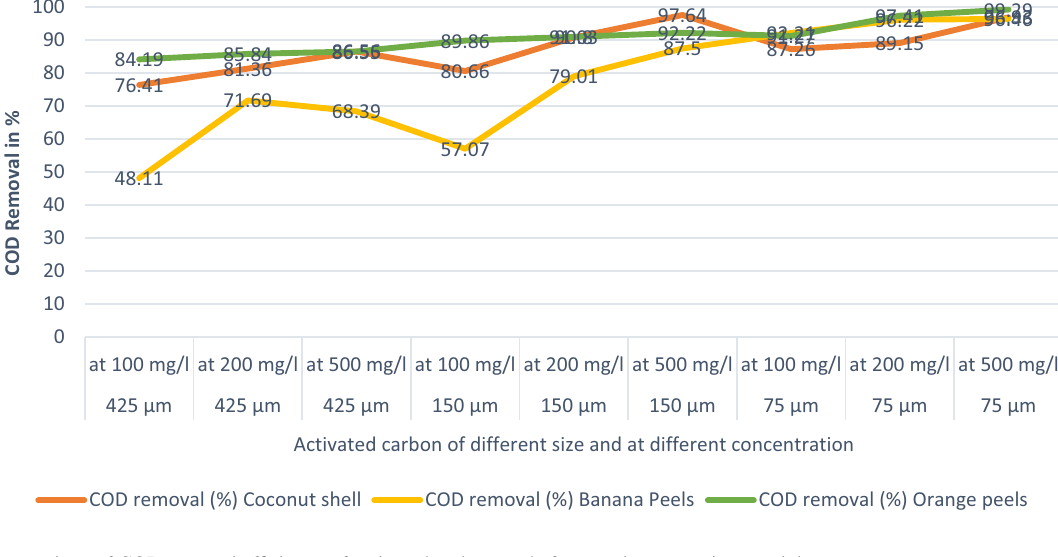
Fig. 10 Comparison of COD removal efficiency of activated carbon made from various organic materials